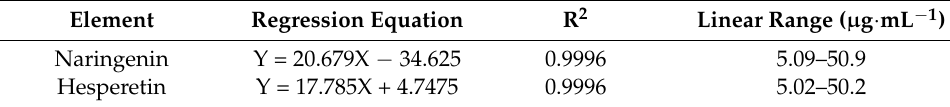
Table 1. Results of linear investigation of naringenin and hesperetin.